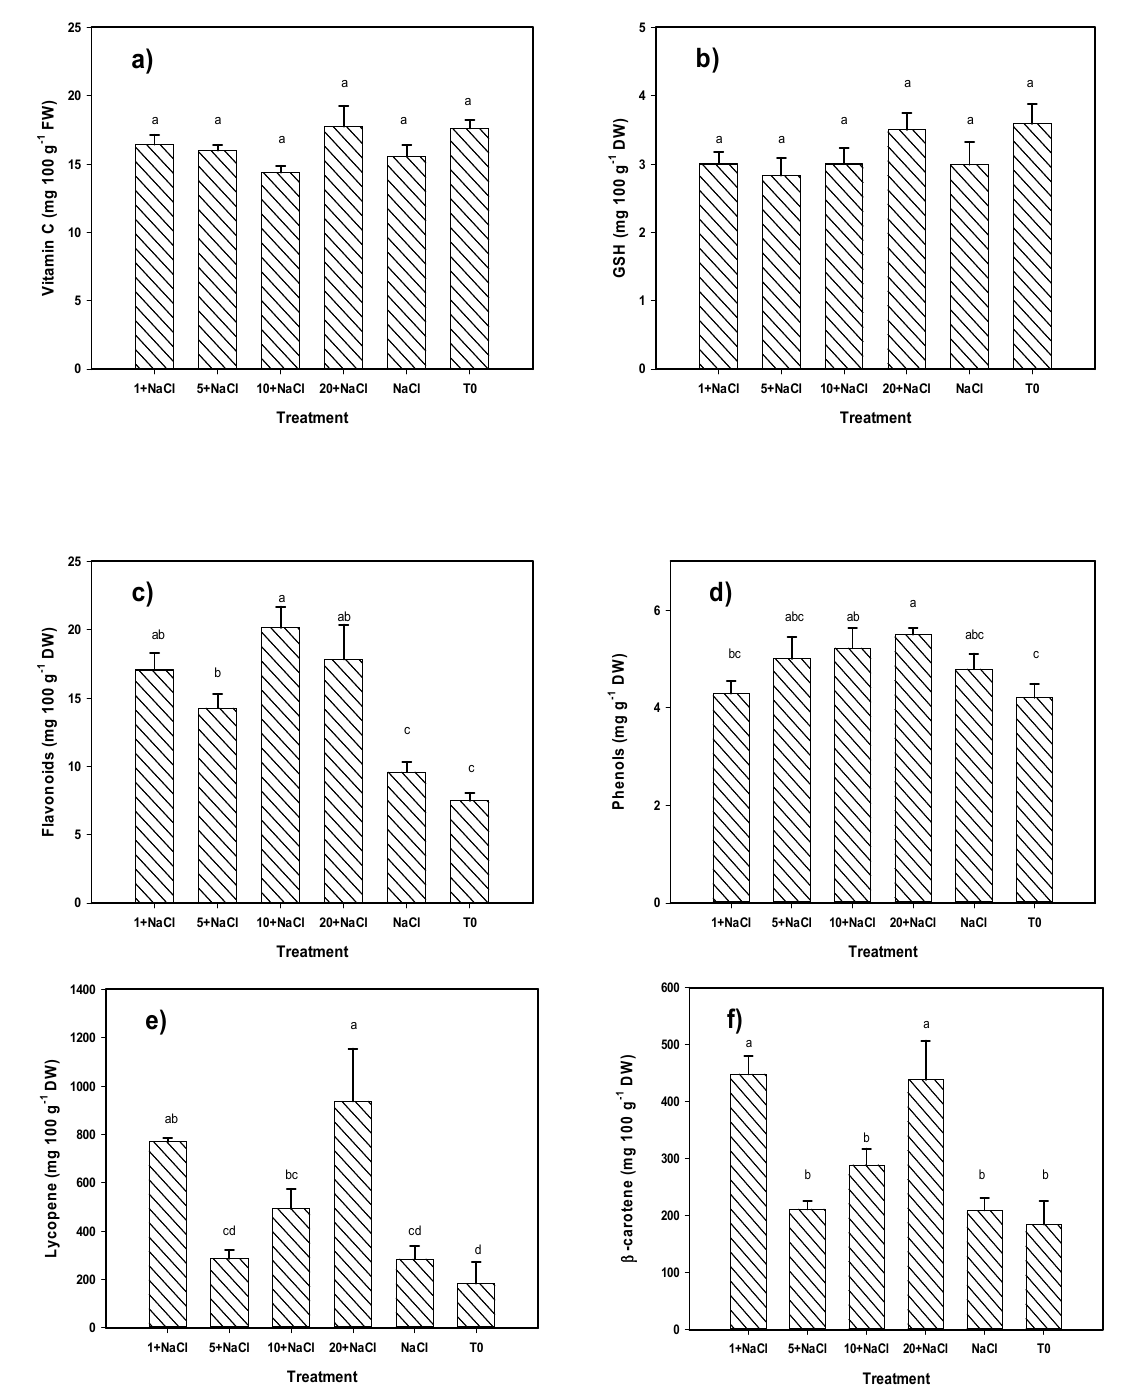
Figure 4. Non-enzymatic antioxidant compounds ( a ) Vitamin C, ( b ) GSH, ( c ) Flavonoids, ( d ) Phenols, ( e ) Lycopene, ( f ) β -carotene) in tomato fruits under NaCl stress and an application of Se NPs. T0: Control. NaCl: NaCl-only treatment. 1, 5, 10, and 20 + NaCl: Represent the amount of Se NPs applied (mg L − 1 ) plus 50 mM of NaCl. FW: Fresh weight. DW: Dry weight. Di ff erent letters per